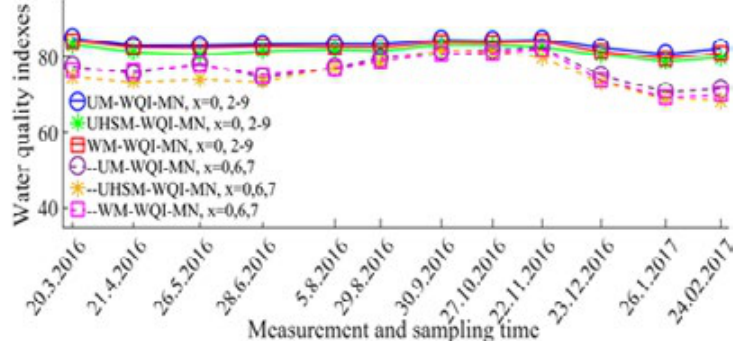
Fig. 9: Change of water quality indices using total coliform as bacterial indicator with three and nine parameters for the station FM with time.